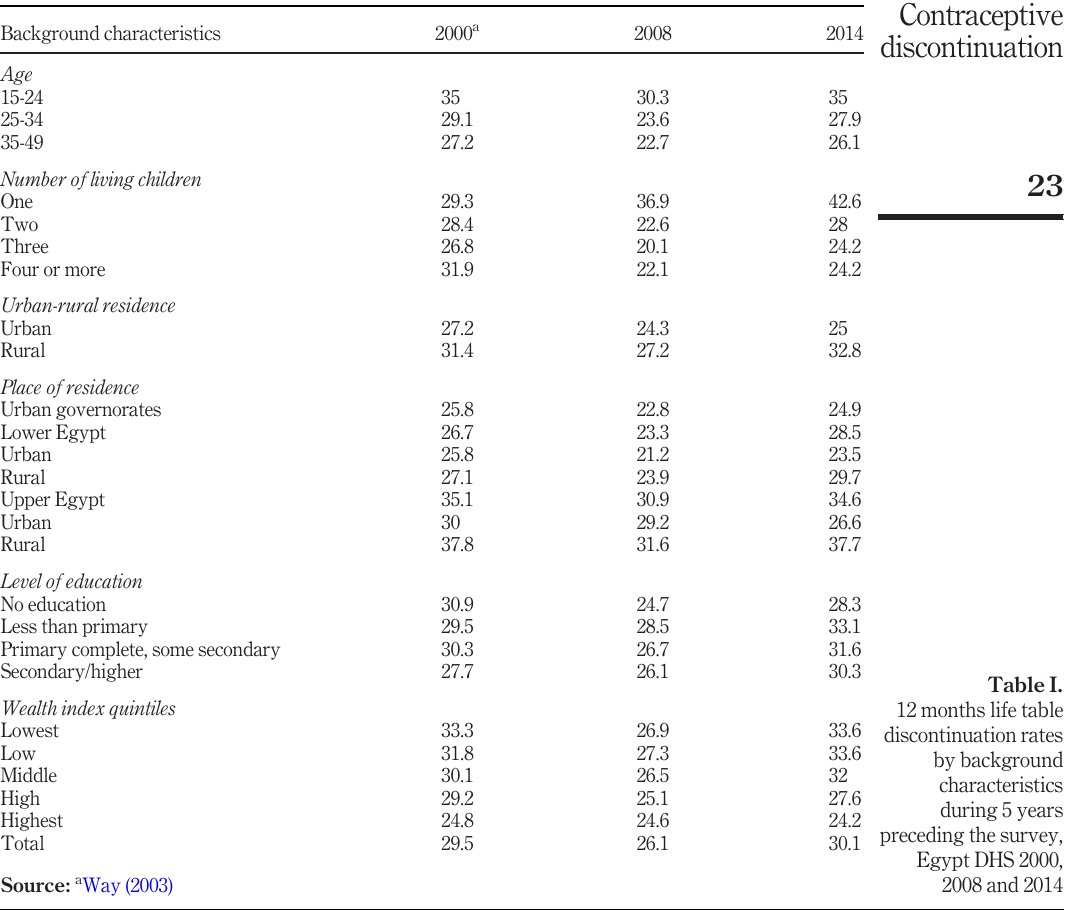
discontinuation rates by